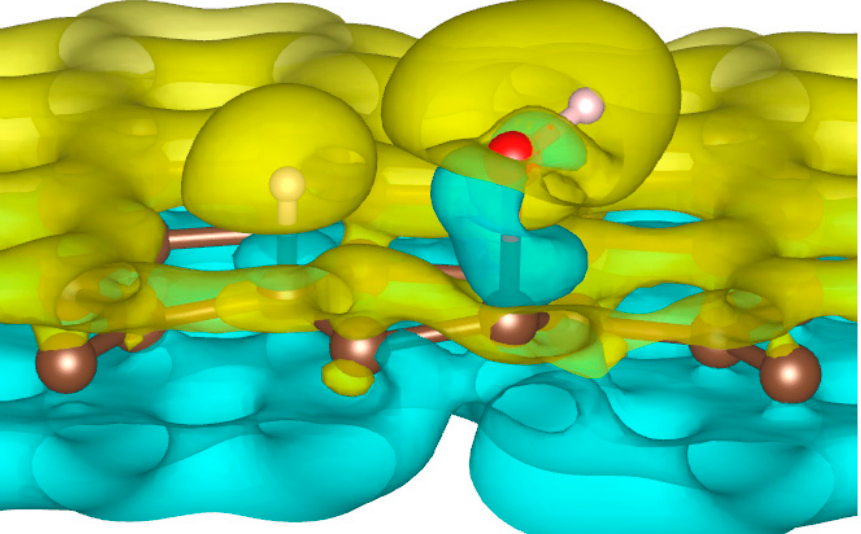
Figure 2. Charge density distribution in the case of dissociated water molecule adsorption on graphene at − 50 eV electric field. Yellow and blue lobes represent, respectively, the positively and negatively charged areas.